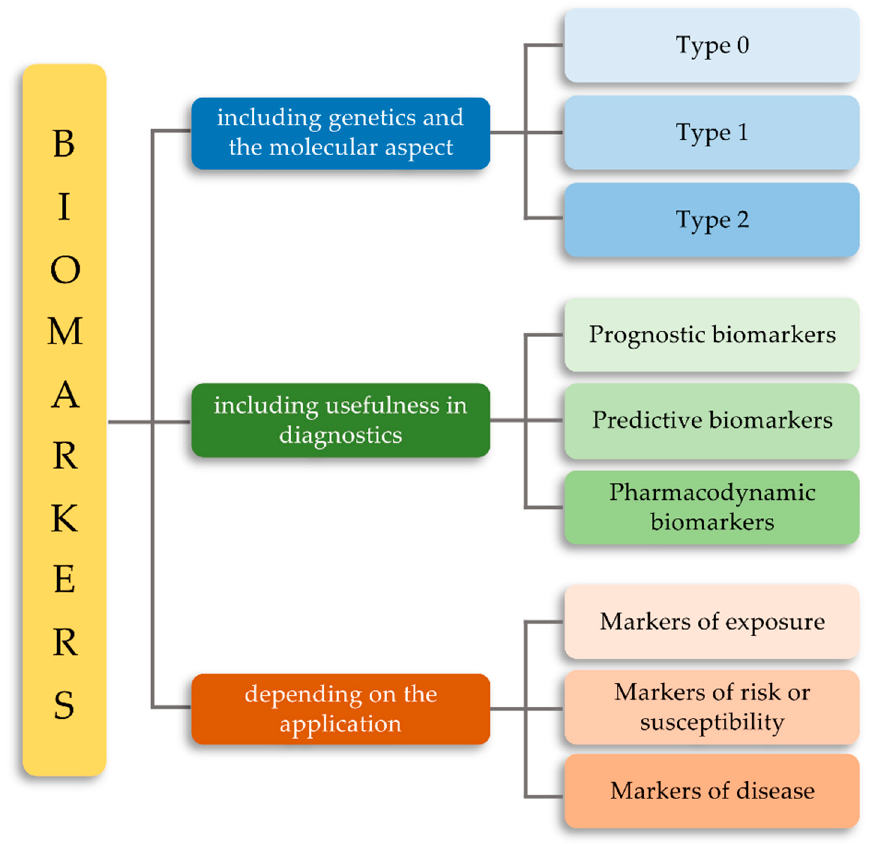
Figure 1. Classification of biomarkers due to the genetic and molecular aspect, the usefulness of biomarkers in diagnostic processes, and application.